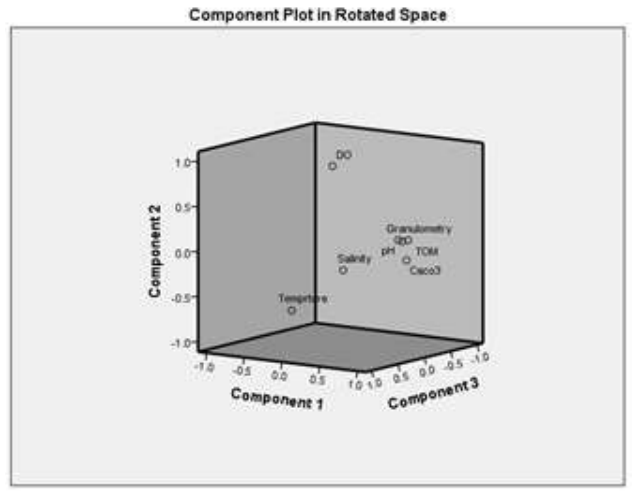
Fig. 3: PCA of environmental factors in southern of Caspian Sea in the sampling period.